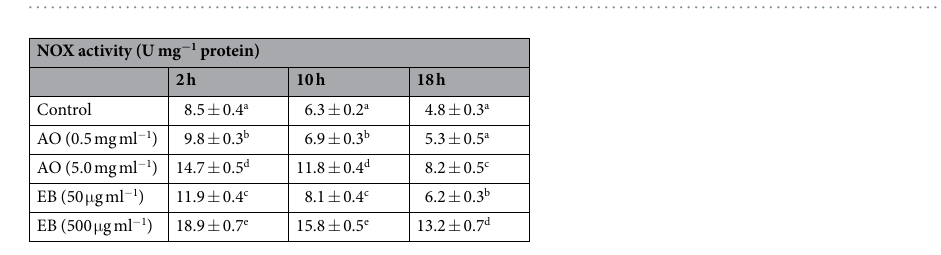
Figure 4. Effects of AO/EB on H 2 O 2 content Effects of AO and EB on H 2 O 2 contents of white ( A ) and purple ( B ) seeds. Bars represent standard deviations of means ( n = 5); means followed by the same letter are not significantly different ( p < 0.05) among treatments. EB, ethidium bromide; AO, acridine orange; H 2 O 2 , hydrogen peroxide.